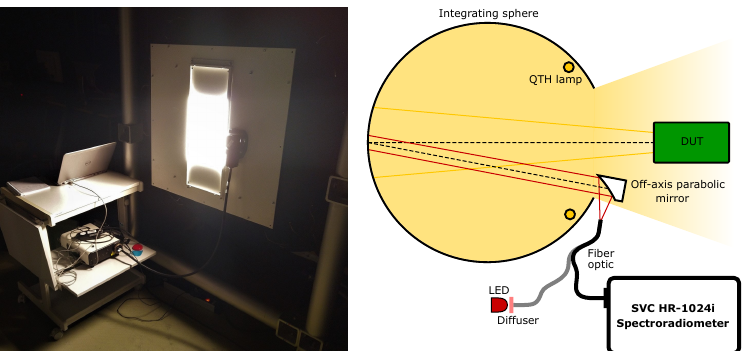
Figure 11. Radiance transfer setup where the calibrated spectroradiometer measures the spectral radiance of a large-aperture integrating sphere. ( left ) Photograph of the integrating sphere aperture with the spectroradiometer and the fiber-optic bundle. ( right ) The field-of-view (FOV) of the spectro- radiometer is aligned to the center of the back of the integrating sphere, such that it overlaps with the FOV of a device under test (DUT).